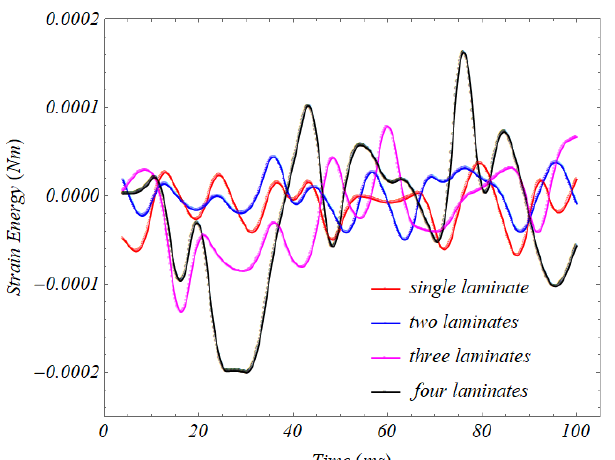
Fig. 8. Strain energy against time for various number of cellphone casing laminates at 1000mm drop distance.